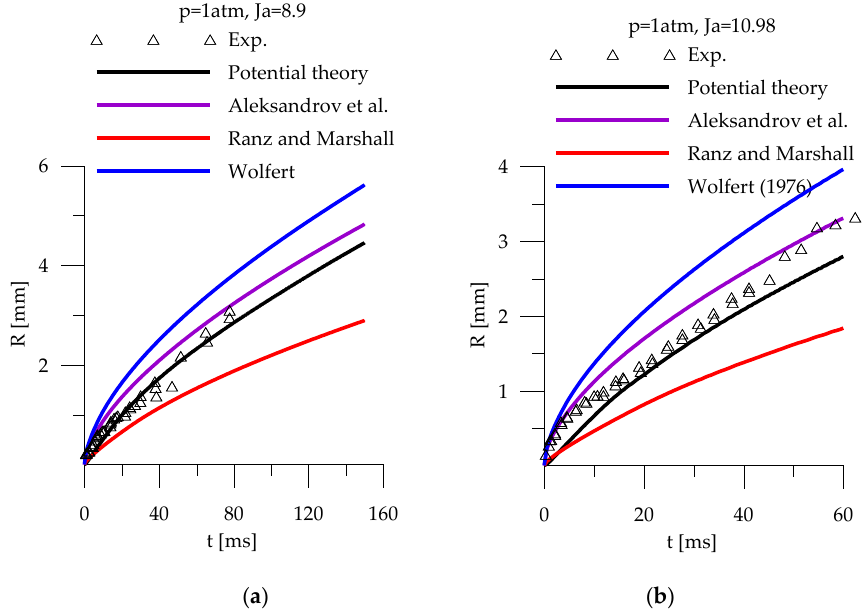
Figure 11. Simulated and measured bubble radius at normal gravity (experimental data from [20]): ( a ) T sup = 3.0 K. ( b ) T sup = 3.9